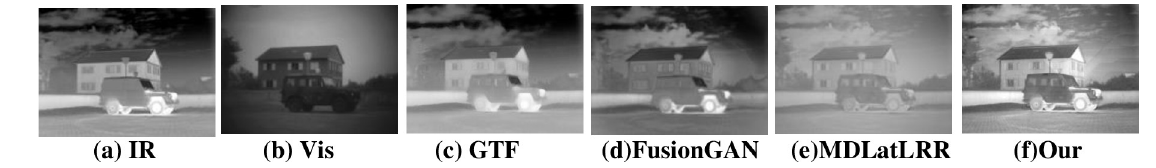
Fig 1. Schematic illustration of image fusion. (a) IR, (b) Vis, (c) GTF, (d) FusionGAN, (e) MDLatLRR, (f)